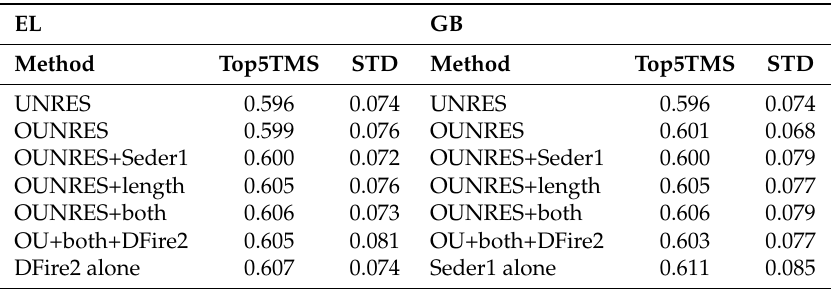
Table 4. Top five mean Template Modeling Scores